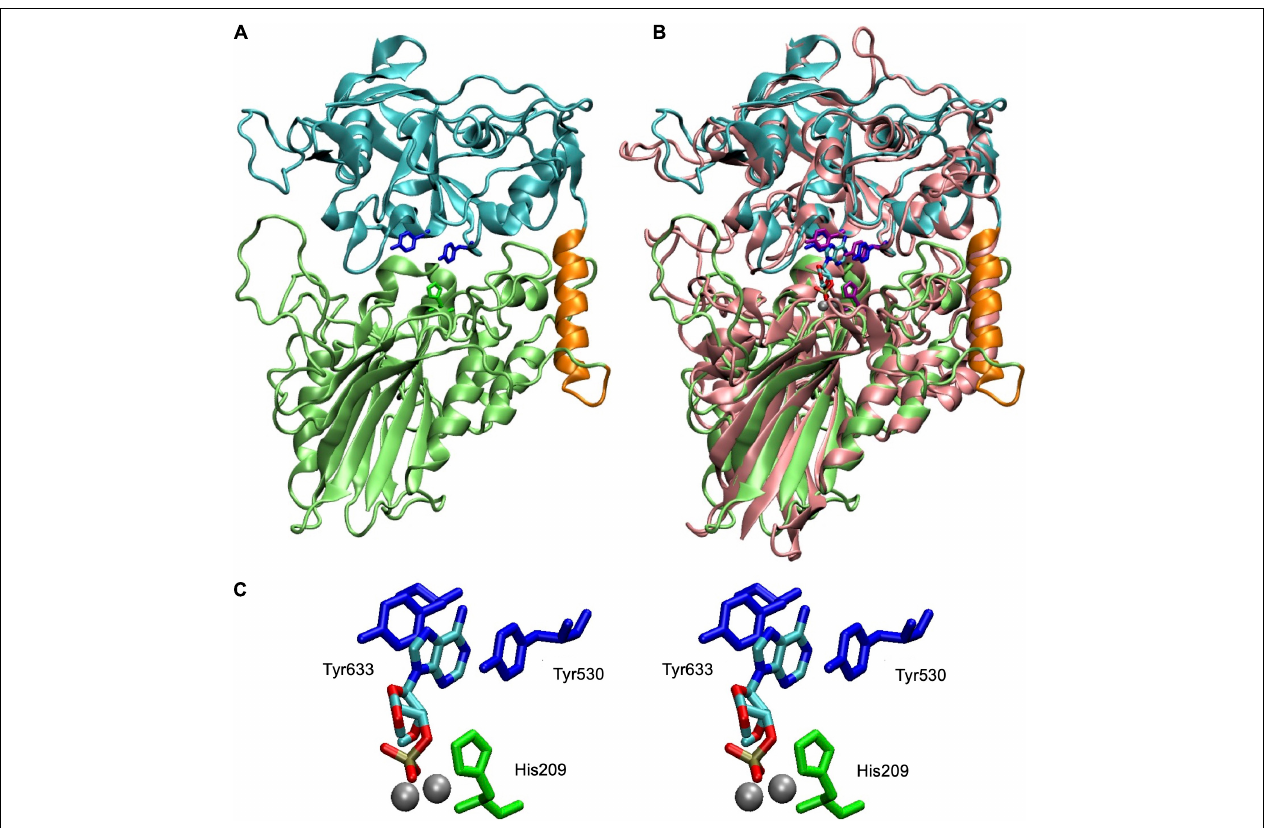
FIGURE 3 | Structure of SntA and fit of 3 (cid:48) -AMP into active site. (A) Homology model covering residues 113–680 of complete SntA protein (GenBank accession AYV64543). Model was built in ORION server (https://www.dsimb.inserm.fr/ORION/) with Modeler (Sali and Blundell, 1993; Ghouzam et al., 2015, 2016) using Protein Data Bank (PDB) ID 3QFK structure as template and includes metallophos (113–426; lime) and 5_nucleotid_C (447–680; cyan) domains and linker region (427–446; orange). Relevant amino acids are highlighted: His209 (in metallophos domain; green), Tyr530 and Tyr633 (both in 5_nucleotid_C domain; blue). (B) Structural alignment of SntA model (panel A) with an Escherichia coli CpdB model with 3 (cid:48) -AMP docked and two Mg ions in the dinuclear metallic center (López-Villamizar et al., 2021). Alignment was generated with MultiSeq plugin (Roberts et al., 2006) of Visual Molecular Dynamics program (Humphrey et al., 1996). CpdB amino acids equivalent to those highlighted in panel (A) are shown (His117, Tyr440, and Tyr544, in CpdB; purple); metals ions are in silver; 3 (cid:48) -AMP is colored by chemical element. (C) Stereogram of SntA relevant amino acids displaying their relationship with 3 (cid:48) -AMP and metal ions (imported from CpdB model). Tyr530 and Tyr633 are amino acids mutated to alanine (single and double mutants) discussed in detail in this paper. His209 is conserved in metallophos domains of many proteins and is needed for catalysis, as known, for instance, from study of CpdB (López-Villamizar et al., 2021). SntA mutant H209A confirmed this role. Figure was prepared with Visual Molecular Dynamics